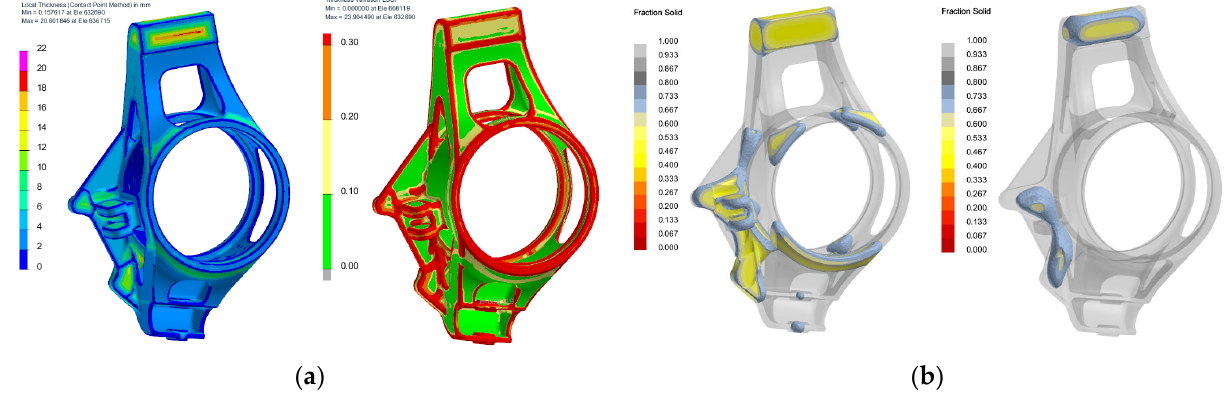
Figure 2. Assessment of the optimized casting shape for the stress conditions of turning and braking (distribution of deformation and equivalent stress).